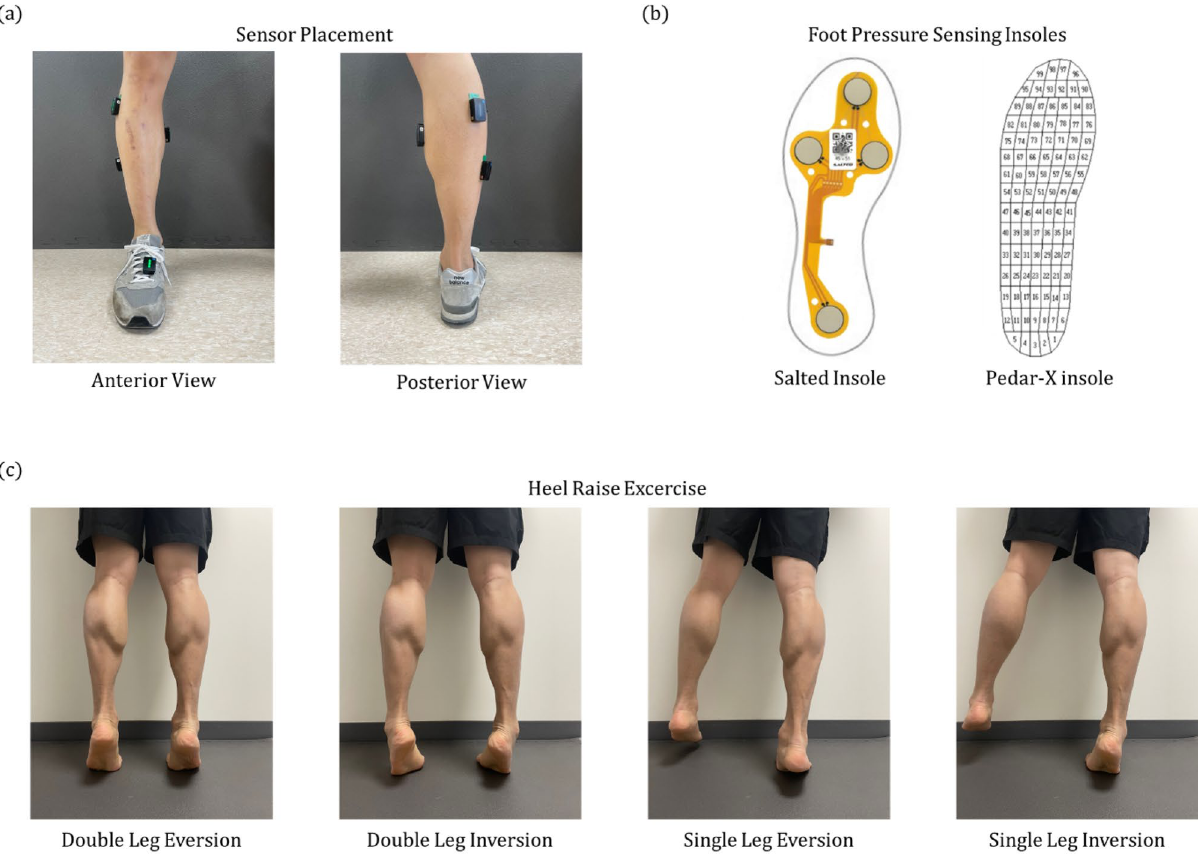
Figure 1. Experimental procedures for heel raise sessions. ( a ) Delsys Trigno sensor placements. The EMG sensors were placed on the PL, GM, GL and SL of the right leg. An additional sensor was placed on the shoe above the dorsal aspect of the 2nd tarso-metatarsal joint in order to quantitatively monitor the foot orientation during heel raise. ( b ) Two foot pressure insoles were used in this study. The sensor arrangements within the insoles are shown for Salted smart insoles and Pedar-X on left and right panels, respectively. ( c ) Heel raise variants. The four different heel raises that were performed DL-EV, DL-IV, SL-EV and SL-IV are shown from left to